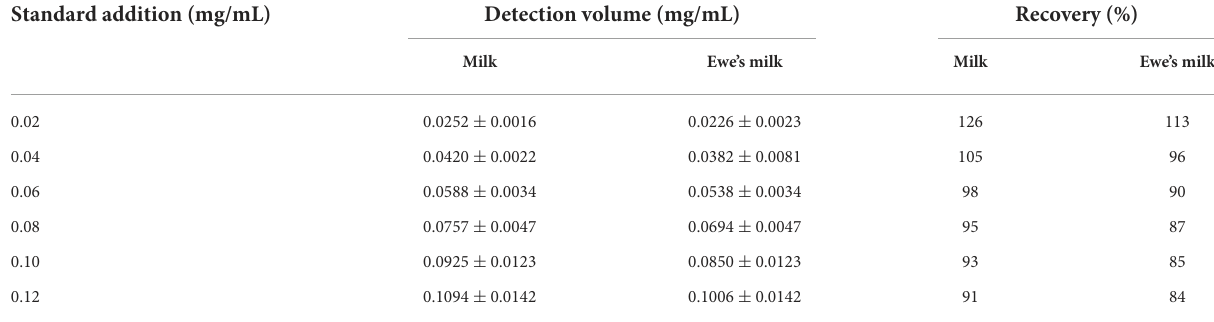
TABLE 1 Results of the SEIRA method based on AgNPs for the determination of glutathione recovery in milk and ewe’s milk. Standard addition